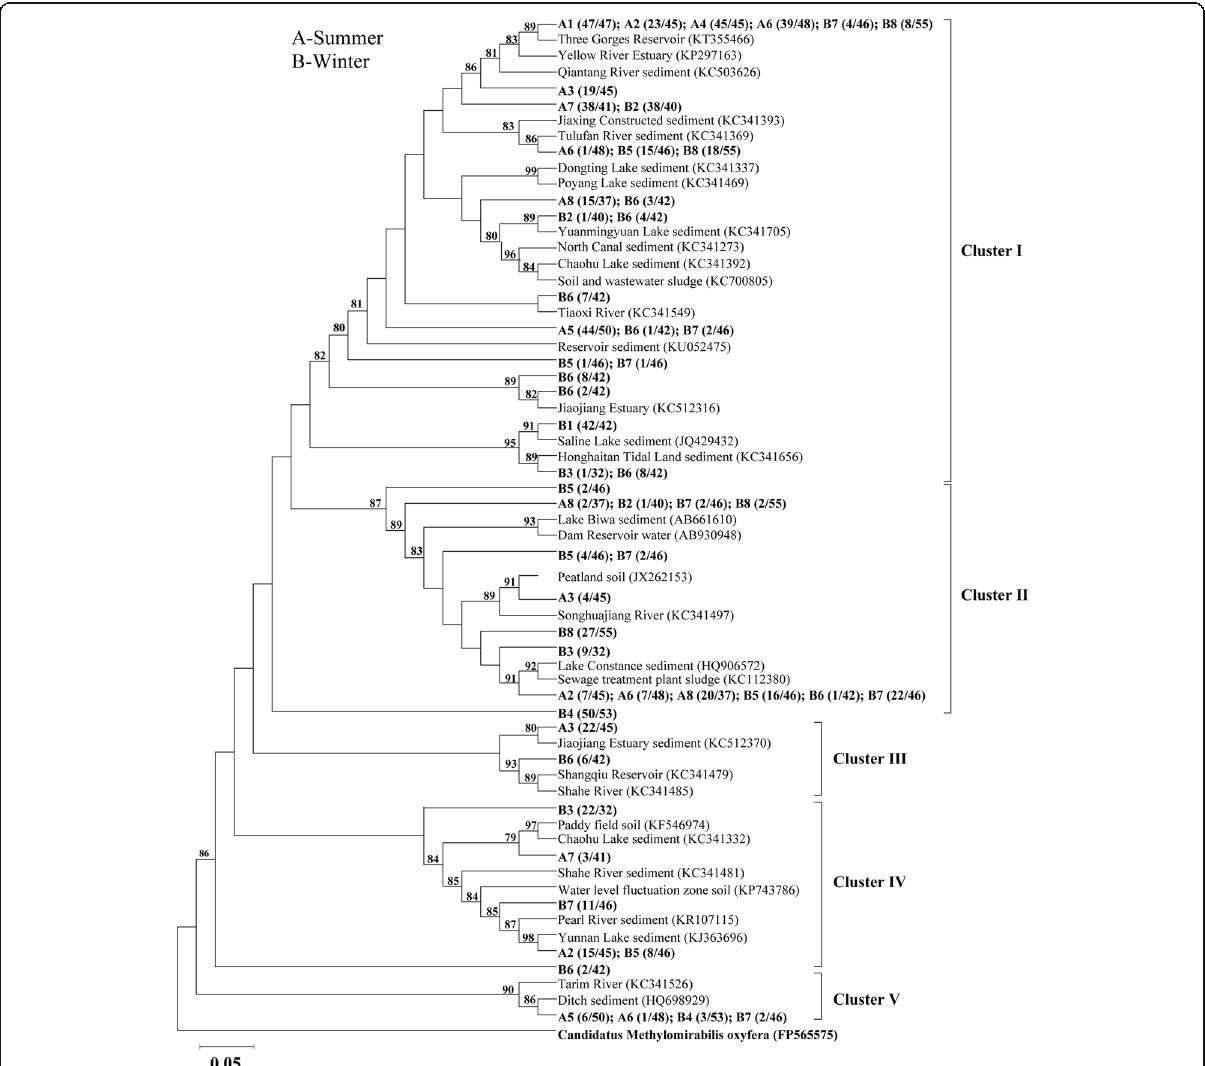
Fig. 5 Neighbor-joining phylogenetic tree showing the phylogenetic affiliations of the pmoA genes. Numbers in parentheses are the number of clones within this OUT. GenBank accession numbers are shown following sequences from other studies. The letter A represents 16S rRNA genes in summer, and the letter B represents the genes in winter. The letter A represents pmoA genes in summer, and the letter B represents the genes in winter. The bootstrap values were based on 1000 replicates; the scale bar indicates the number of nucleotides substitutions per homologous